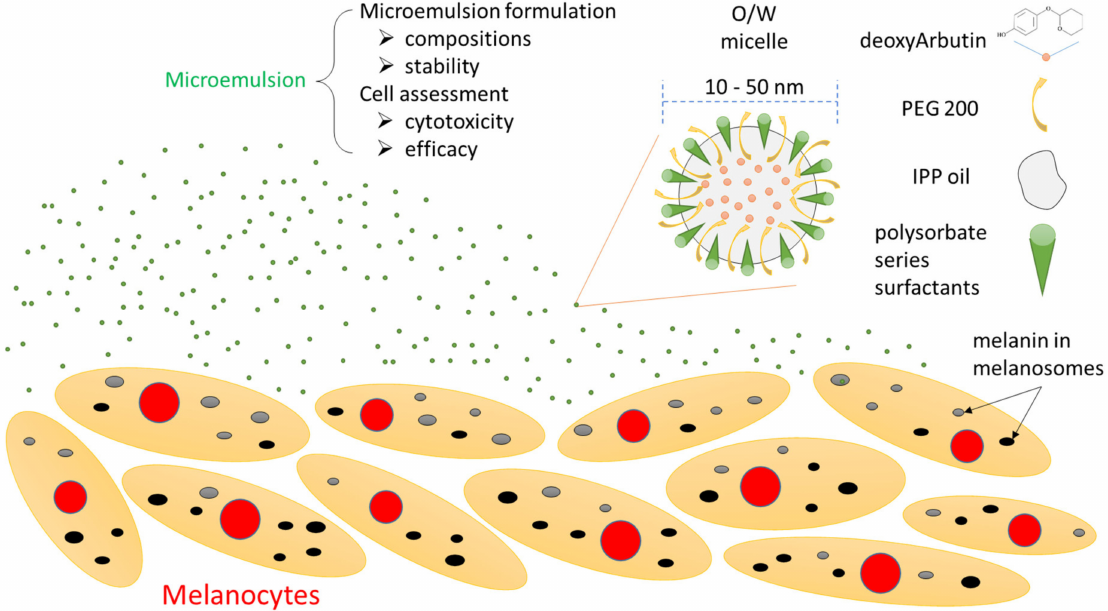
Figure 8. Summary of the cell-based system used to directly assess the effects of the microemulsions encapsulating